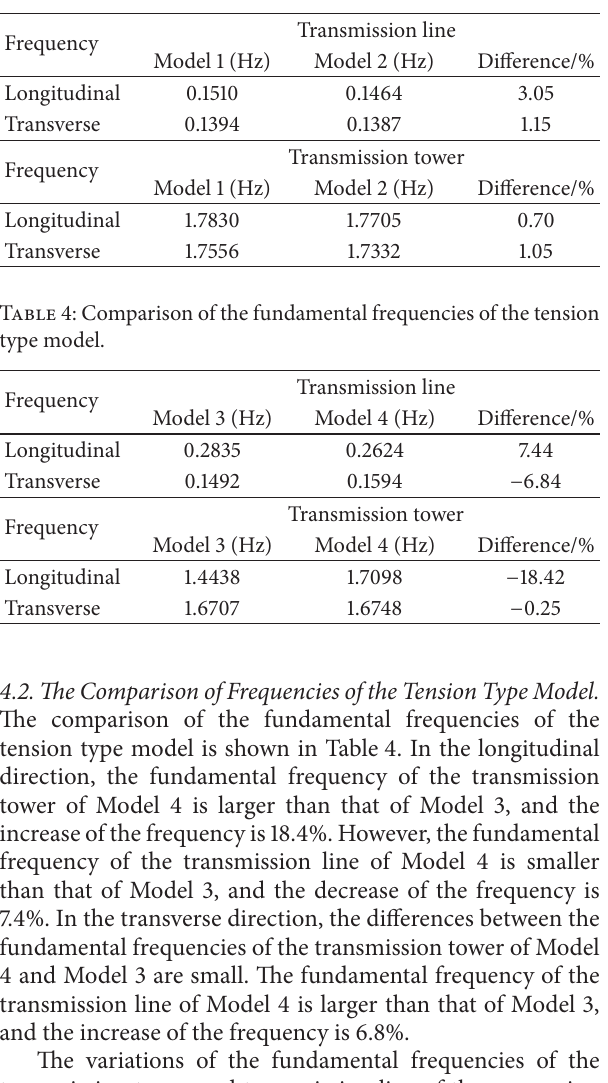
Table 3: Comparison of the fundamental frequencies of the suspen- sion type model.